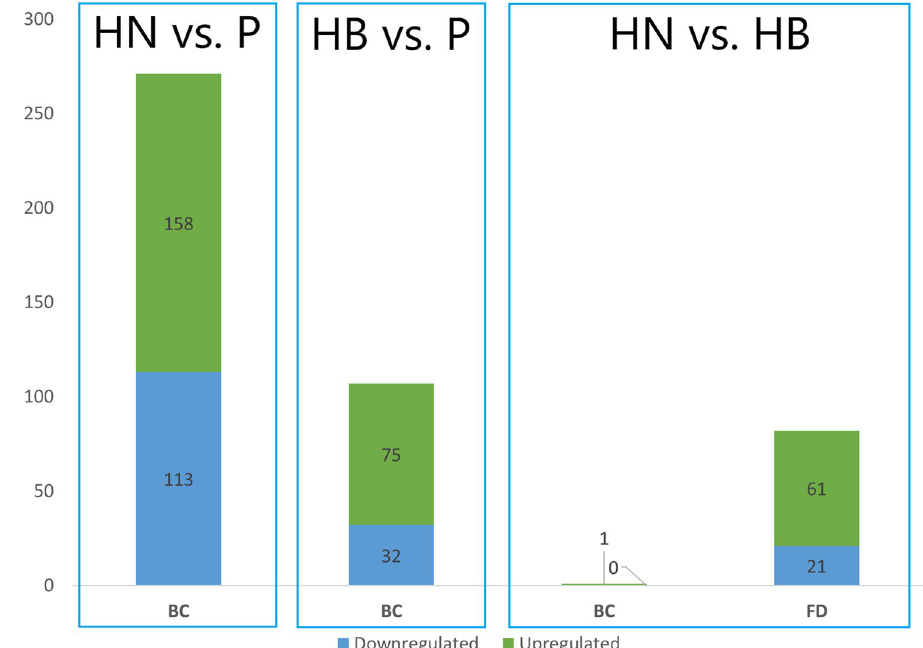
Figure 5. Differentially expressed genes in comparisons between the three phenotypes within each muscle region. BC back central region, FD front dorsal region, HN high color-no banding fish, HB high color-banded fish, P Pale